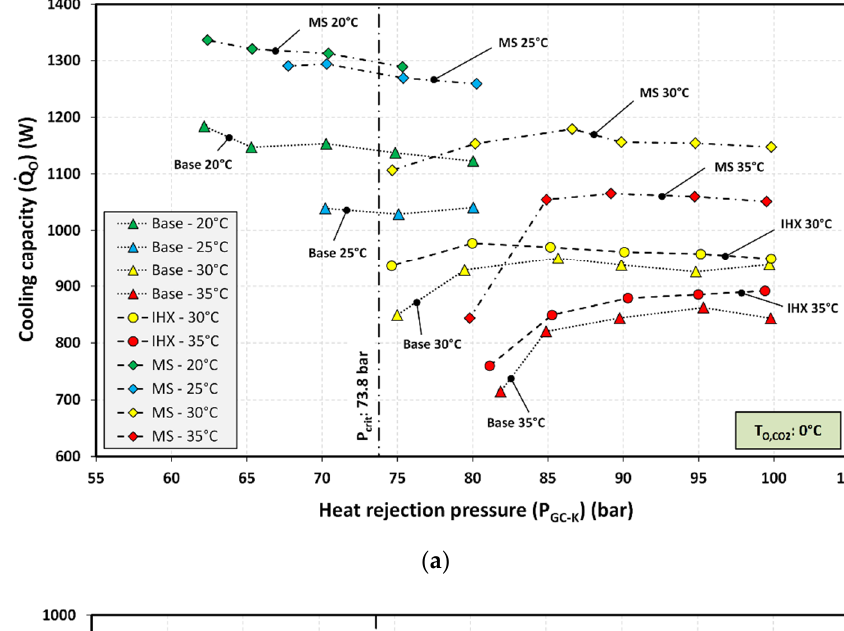
. Q O ) of the refrigerating plant at 0 ◦ C ( a ) and − 10 ◦ C ( b ).